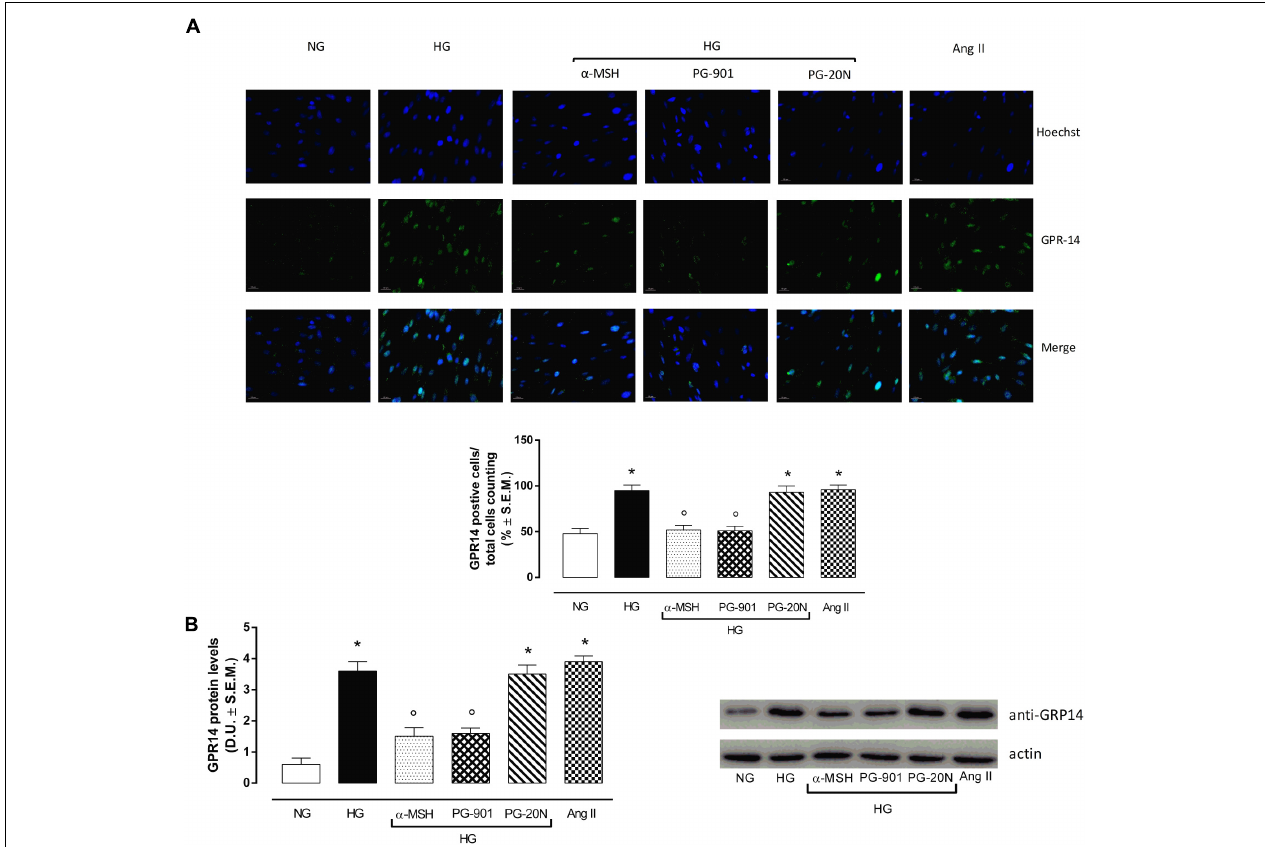
FIGURE 3 | Urotensin II receptor immunocytochemistry and Western Blotting Assay. (A) Representative immunofluorescence images (20X; in blue Hoechst for nucleus and in green GRP14 for Urotensin II receptor labeling) show that H9c2 cells exposed to high glucose (33 mM D -glucose) exhibited an evident increase Urotensin II levels, highly expressed in hypertrophic cardiomyocytes compared to cells exposed to normal glucose (5.5 mM D -glucose). MC5R agonism with α -MSH (90 pM) and PG-901 (10 − 10 M) treatment significantly decreased Urotensin II labeling in H9c2 cells exposed to high glucose. MC5R antagonist PG-20N treatment in H9c2 cells exposed to high glucose showed high Urotensin II levels. The percentage of positive cells was calculated by the number of labeled positive cells of 300 cells in four different microscope fields. (B) Western Blots analysis detecting GPR-14 protein levels confirmed the elevated protein expression of Urotensin II receptor in hypertrophic H9c2 cells; this was significantly reduced in H9c2 cells exposed to high glucose and treated with MCR5 agonists. Values are expressed as mean ± S.E.M. of n = 9 values, obtained from the triplicates of three independent experiments. NG, normal glucose; Ang II, angiotensin II; HG, high glucose; D.U., Densitometric Units; ∗ P < 0,01 vs. NG; ◦ P < 0,01 vs.